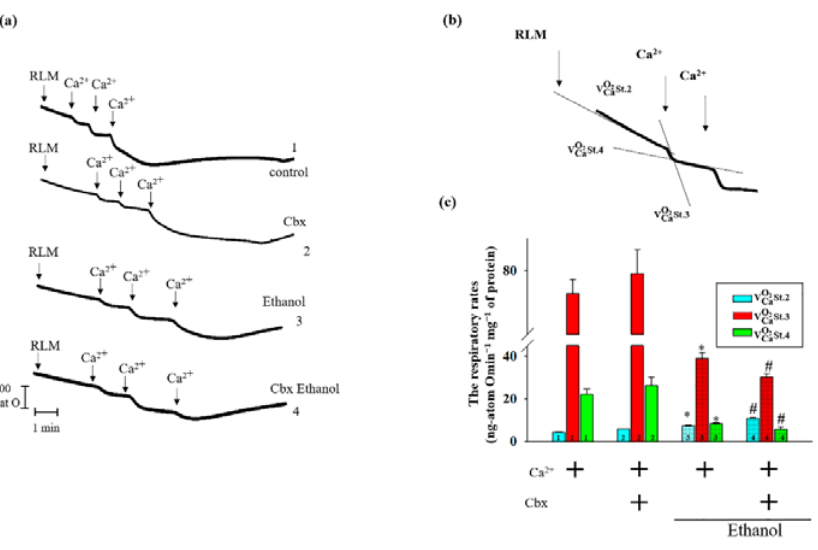
Figure 3. Effect of Cbx on respiratory activity in RLM. The conditions were the same as in Figure 1. ( a ) Representative curves of respiratory activities. ( b ) A schema of calculation of oxygen consumption rates in states 2–4 (V O 2 St.2, V O 2 St.3 and V O 2 St.4). ( c ) Quantitative analysis of respiratory activity in Ca Ca Ca Control and Ethanol RLM in the presence/absence of Cbx. The values shown are the means ± SD from three independent experiments; * p ≤ 0.05 compared with the control value in the RLM without additions (columns 1); # p ≤ 0.05 compared with the control value in the Ethanol RLM without additions (dotted columns